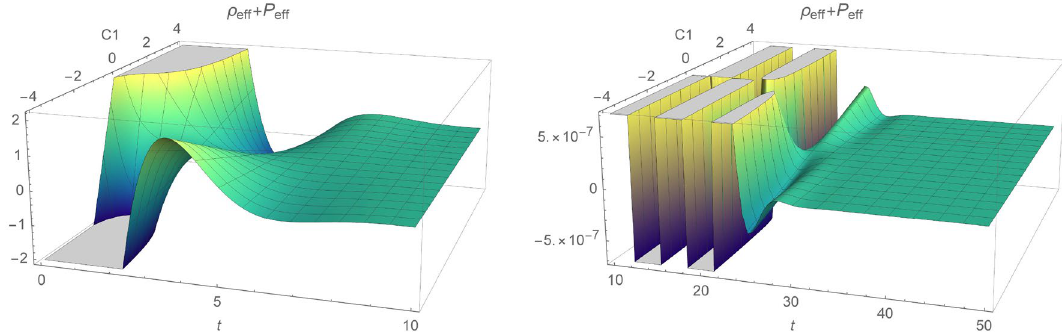
Figure 7. Plot of NEC for t 0